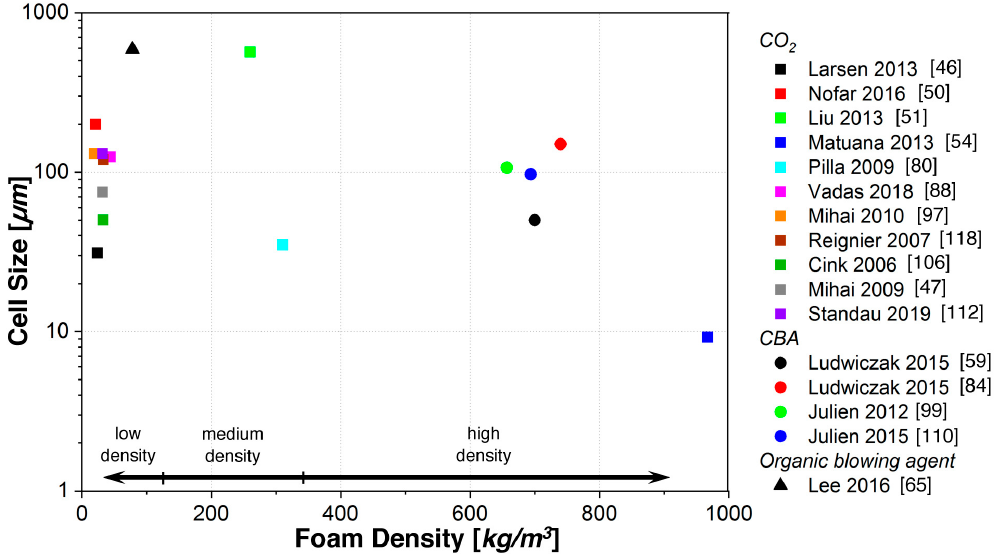
Figure 5. Overview of the literature on extrusion-foamed PLA (lowest density values with corresponding cell sizes within the given range were considered).